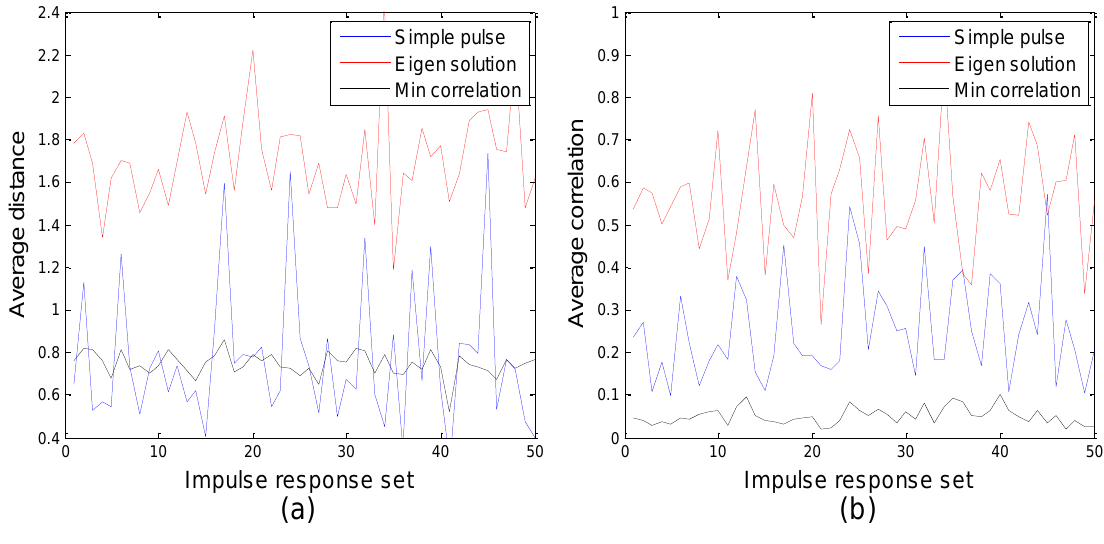
Figure 7. Comparison of (a) the average Euclidean distance and (b) the average correlation between the ideal echoes for different waveform design